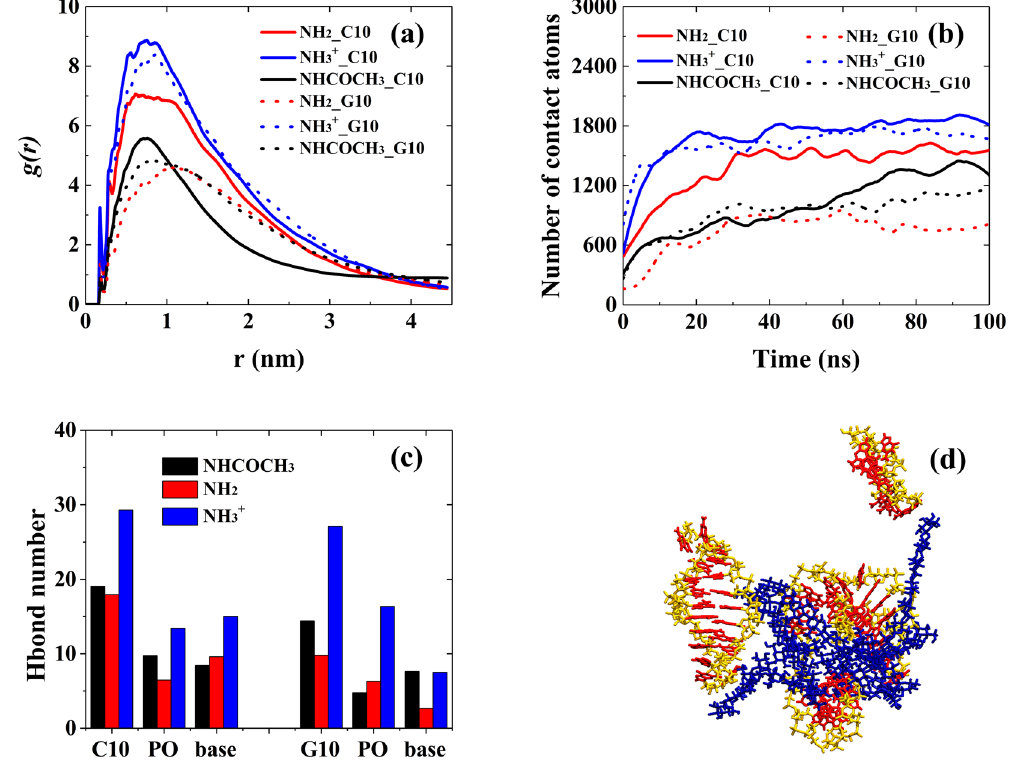
Figure 7. ( a ) The RDFs of C10/G10 around different types of chitosan. ( b ) Number of contact atoms between chitosan and C10/G10 as a function of simulation time. ( c ) Inter-molecular H-bond numbers between functional groups in chitosan and different parts of nucleotide (C10/G10: total number of H-bond formed between chitosan and C10/G10; PO: phosphate; base: guanine or cystosine). ( d ) The snapshots of –NH2 chitosan/G10 system at the end of 100 ns MD simulation (blue: chitosan, yellow: G10, red: base). All bases in G10 were displayed in red to better understand the role of base-base interaction in aggregation of G10. Water molecules were omitted for